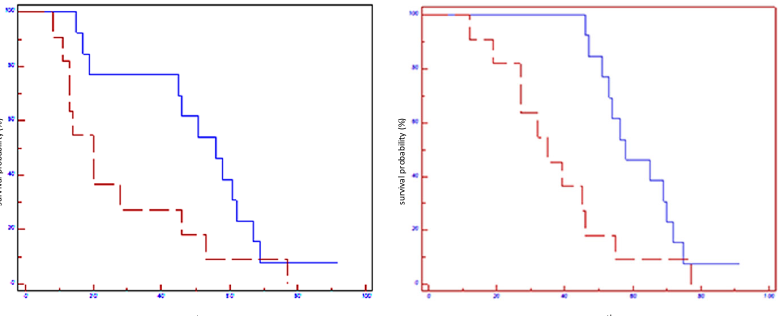
Figure 3. Prognostic impact of miR101 ‐ 3p on EFS (on the left) and on OS (on the right) in all population: blue line refers to patients with overexpression of miR101 ‐ 5p; red line refers to patients without overexpression of miR101 ‐ 5p.